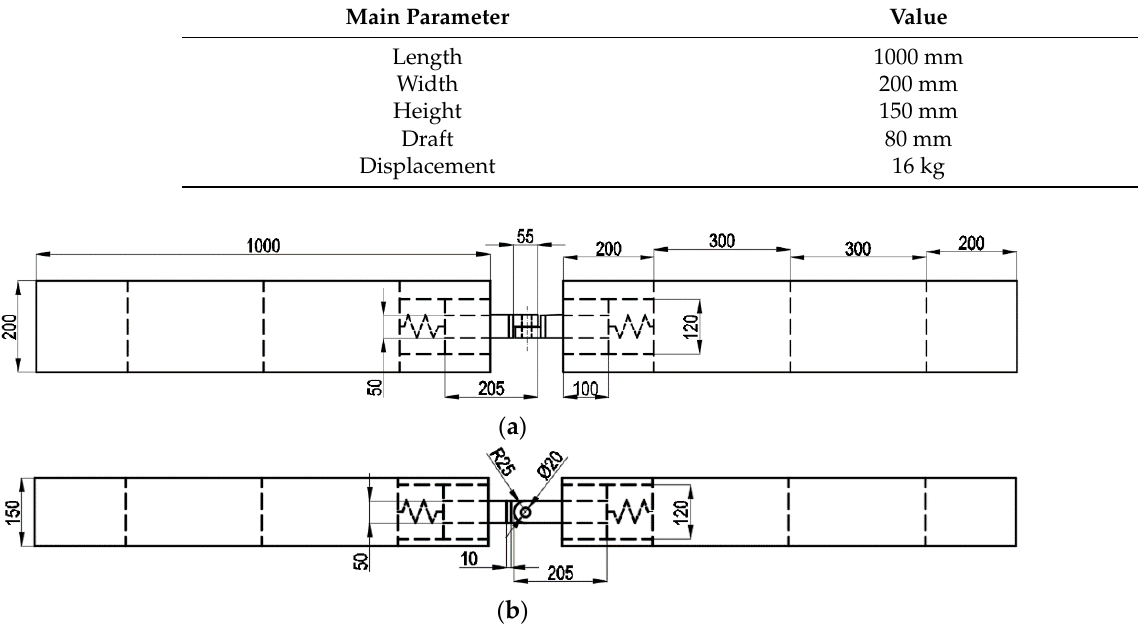
Figure 1. Model of double module box floating structure: ( a ) top view; ( b ) front view. Table 1. Main dimensions of a single module model. Main Parameter